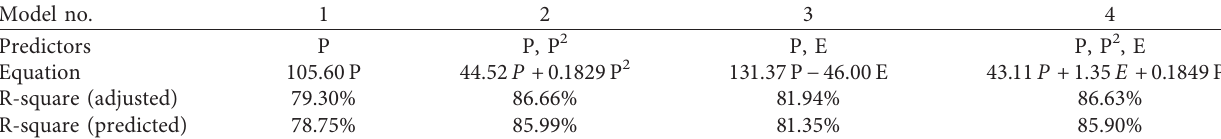
Table 2: Summary of the regression models to predict water inflow by precipitation (P) and evaporation ( E ). Model